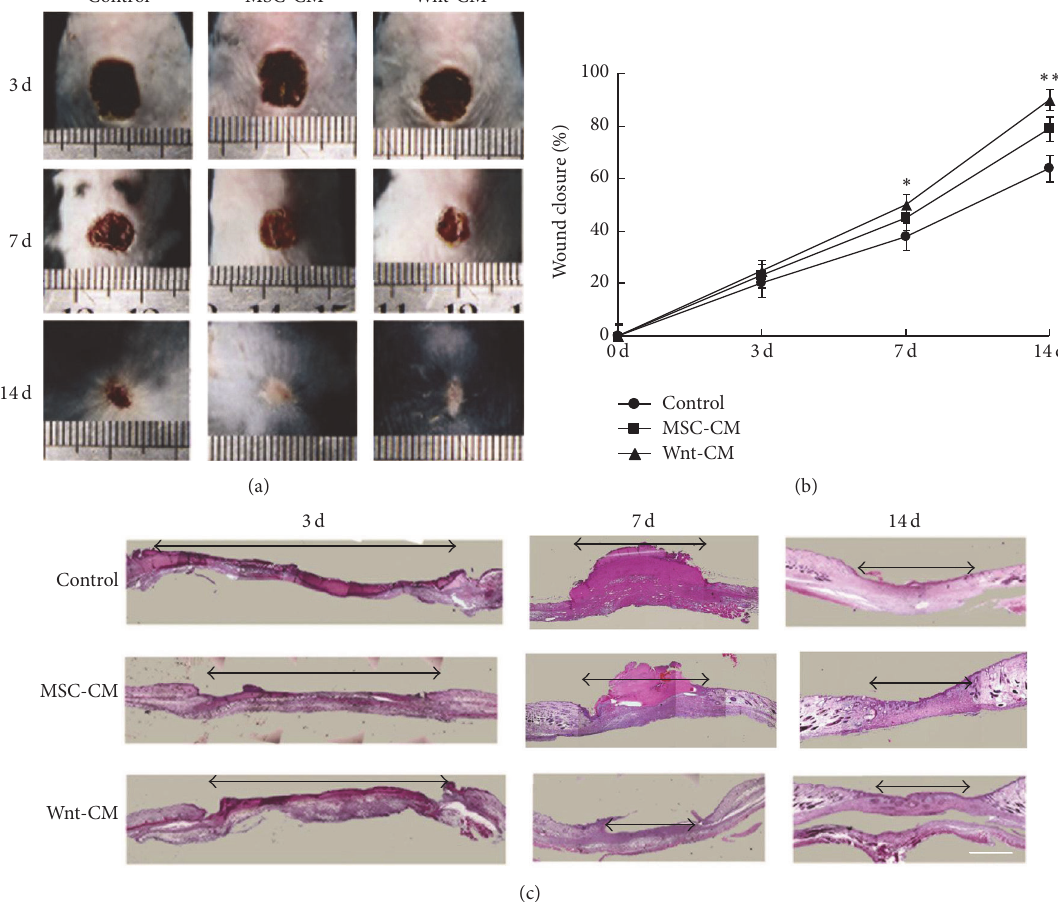
Figure 2: Topical injection of Wnt-CM accelerated healing of full-thickness skin wounds in mice. (a) Typical images of dorsal skin showing effectiveness of wound closure in the mice of treatments groups DMEM, MSC-CM, and Wnt-CM. (b) The percentage of wound closure on days 3, 7, and 14 after the surgical injury. (c) On postinjury days 3, 7, and 14, healing skin was examined by H&E staining of the tissue slices. The data are presented as mean ± SEM, 𝑛 = 3 ; ∗ 𝑃 < 0.05 and ∗∗ 𝑃 < 0.01 . The double arrow line denotes the wound area. The scale bar is 500 𝜇 m in panel